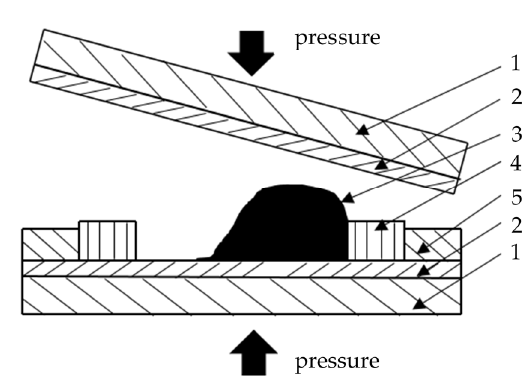
Figure 2. Structure of the mould and a method for casting methacrylic adhesive plates: 1—stiff plate,